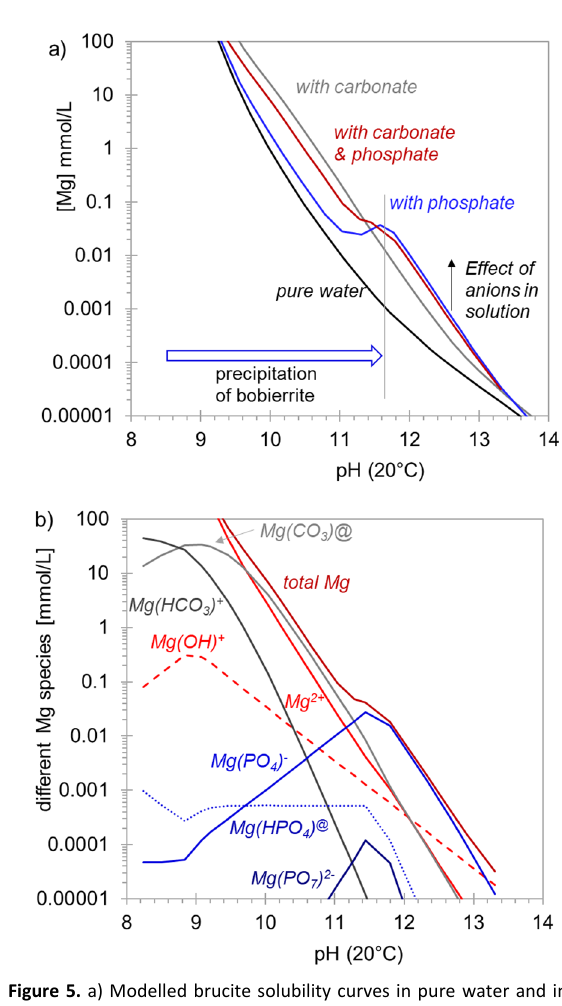
Figure 5. a) Modelled brucite solubility curves in pure water and in carbonated solution (CO3 2 ‐ = 80 mmol/L) and with phosphate (3 wt. % of NaHMP), b) different Mg species associated to the solubility of brucite in carbonated and phosphate solution (CO3 2 ‐ = 80 mmol/L and 3 wt. % of NaHMP). Adapted from